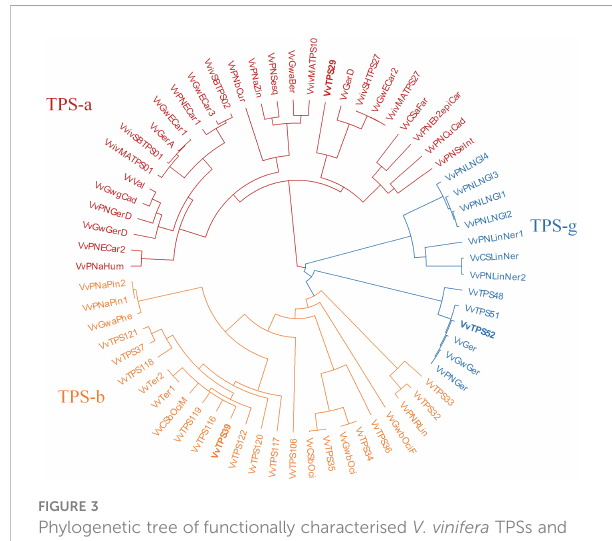
FIGURE 3 Phylogenetic tree of functionally characterised V. vinifera TPSs and VvTPSs identi fi ed in QTLs of interest from this study. The tree is coloured according to TPS-subfamilies: TPS-a subfamily is in red, TPS-b is orange and TPS-g subfamily is blue. Candidate genes are shown in bold typeface.